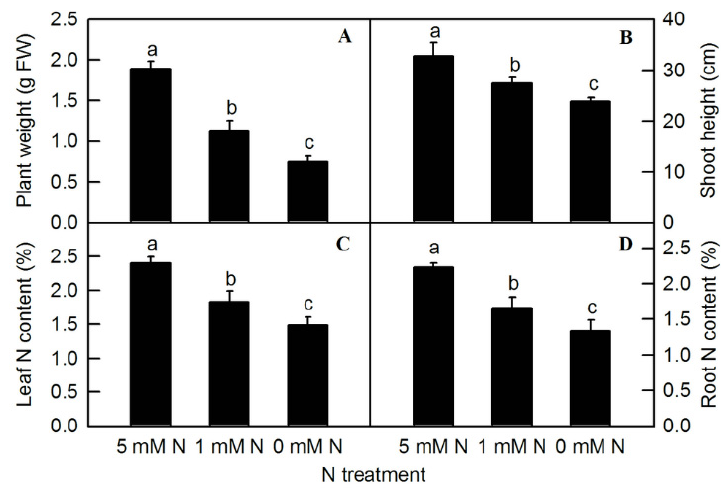
Figure 2. Effects of N deficiency on plant weight ( A ), shoot height ( B ), leaf N content ( C ), and root N content ( D ) in O. sativa . Bars represent means ± SD ( n = 4). Difference among the treatments was analyzed by Duncan’s multiple range test. Different letters above the bar indicate a significant difference at p < 0.05.